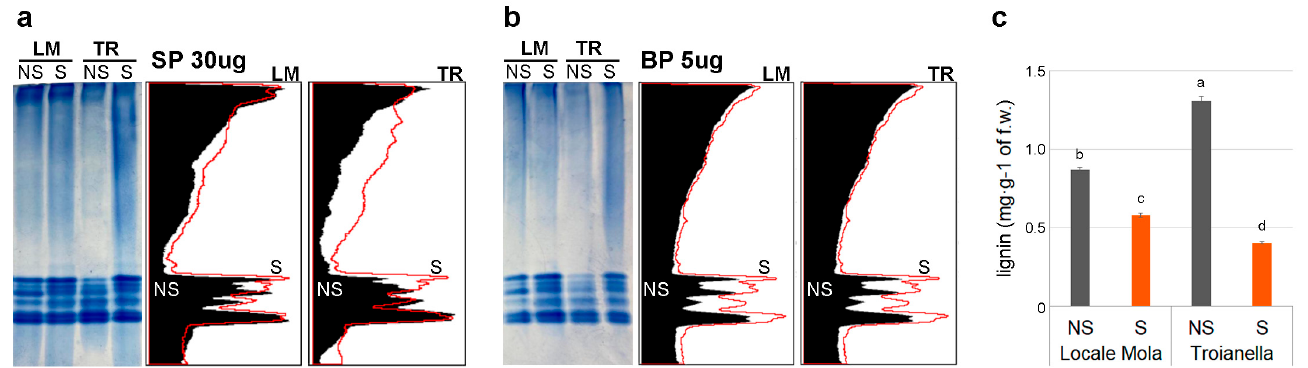
Figure 8. Analysis of artichoke peroxidase activity and lignin content accumulation in Locale di Mola (LM) and Troianella (TR) artichoke samples. Native-PAGE of ( a ) 30 µg of soluble (SP) fraction and ( b ) 5 µg of bound (BP) protein fraction of the LM and Troianella TR ecotypes. POD activity assay staining of gels was analyzed by ImageJ software to compare POD activity in non-sanitized (NS, black profile) and sanitized (S, red profile) plants. The histogram shows ( c ) lignin content in each condition tested. Letters indicate statistically significant differences for p ≤ 0.05 performing a Tukey post hoc ANOVA test.